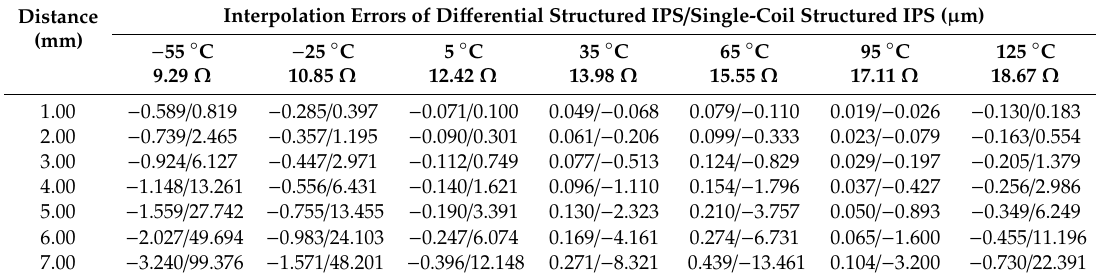
Table 4. Mapping of interpolation errors on